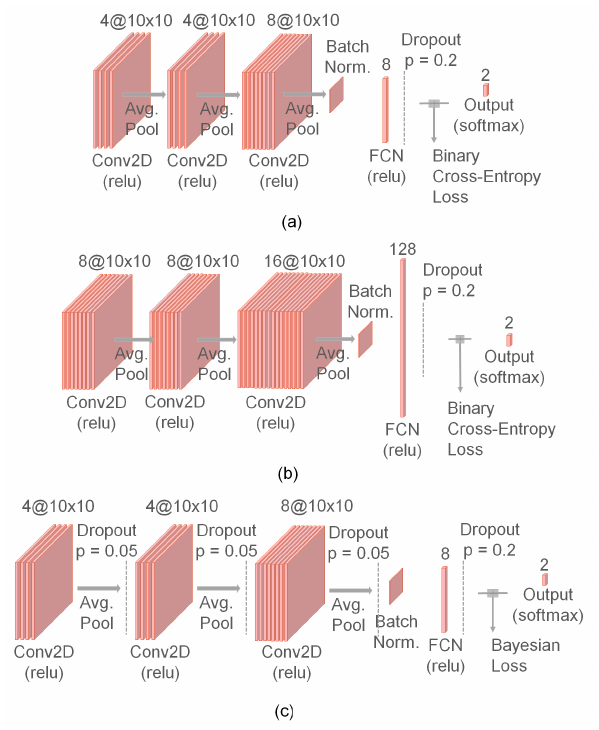
Figure 2. Examples of the deep learning architectures explored in this manuscript. ( a ) Rad’s model [26], ( b ) WiderNet 2 × , FCN 128, ( c ) Bayesian Approach to Rad’s model. The WiderNet type of architecture is also explored with variants containing eight nodes in the FCN layers in addition to the variant with 128